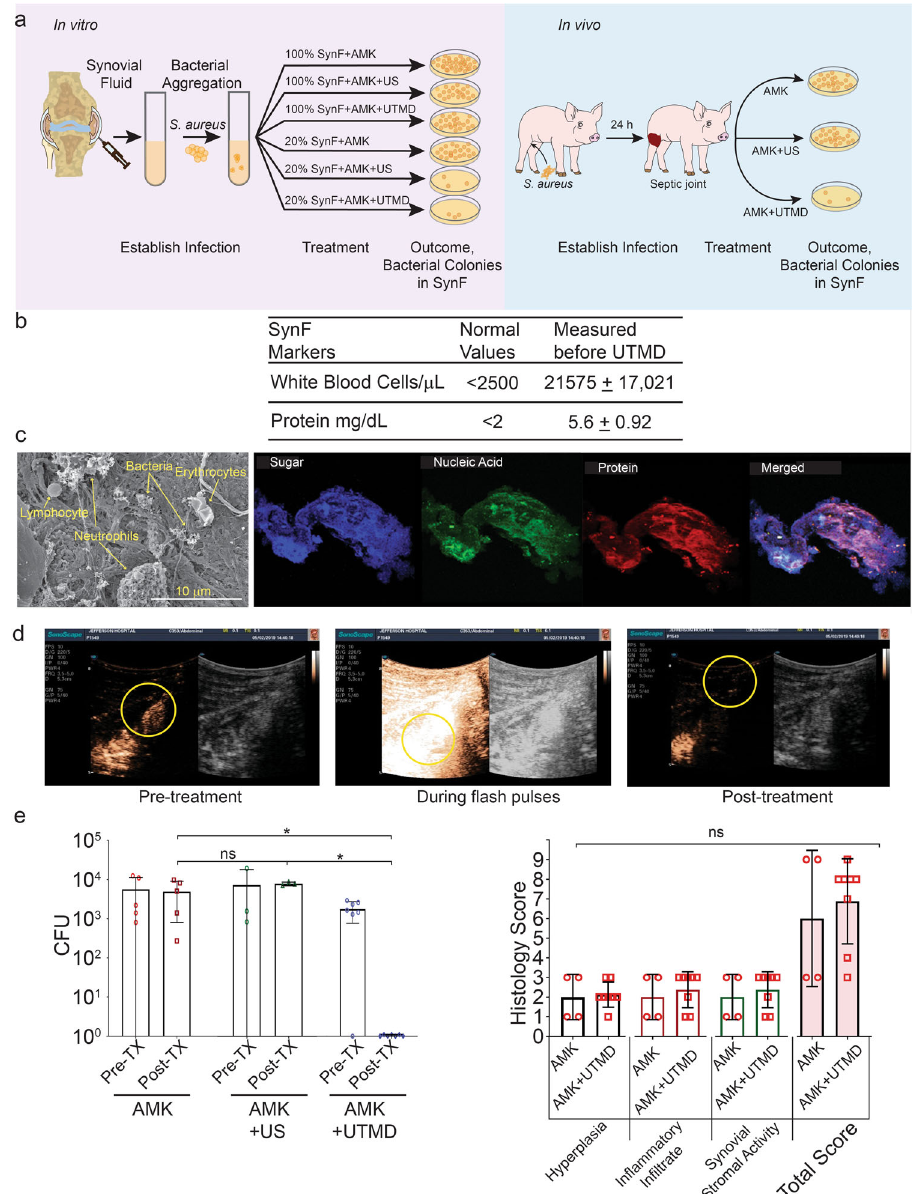
Fig. 5 S. aureus aggregates and microbubble cavitation in a pig model. a (created with BioRender) Cartoon showing comparative in vitro and in vivo treatments. Note that ultrasound + AMK alone is effective in vitro but required AMK + UTMD in vivo. b SynF markers before treatment. c Representative scanning electron micrograph of 24 h pre-treatment S. aureus aggregates in the septic joint. Shown are fi brous S. aureus aggregates containing neutrophils, lymphocytes, and erythrocytes. Representative confocal images of an S. aureus aggregate from a septic joint. Three-color imaging shows the abundance of sugars, proteins (representative of extracellular matrix), and nucleic acids (representative of extracellular DNA). The merged image shows their relationships. d Microbubbles (within yellow circle) in SynF in septic joint. e Average recovered CFU in infected joints after treatment with AMK alone ( n = 5), AMK with insonation (AMK + US; n = 3), or AMK with UTMD (n = 7). Comparison of average histological scores for synovium from septic joints treated with AMK alone ( n = 4) or AMK + UTMD ( n = 8). Individual data points are shown as open, colored symbols. Values are means ± standard deviation. Comparisons done using Kruskal – Wallis test for multiple comparisons. ns, P > 0.05; * P < 0.05; ** P < 0.01; *** P < 0.001; **** P <